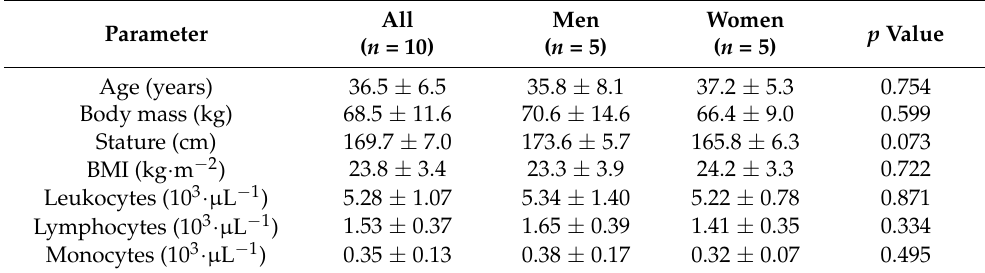
Table 1. General characteristics of participants in the study.